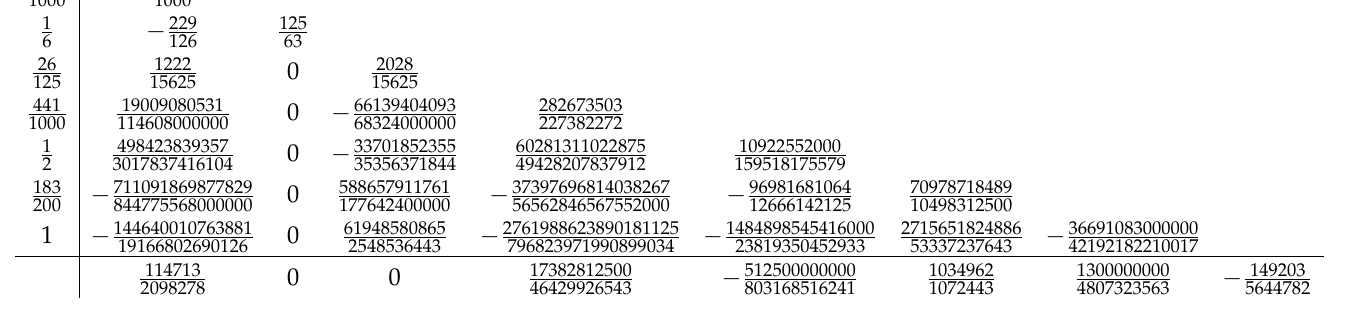
Table 2. The Butcher tableau of the optimised Runge–Kutta